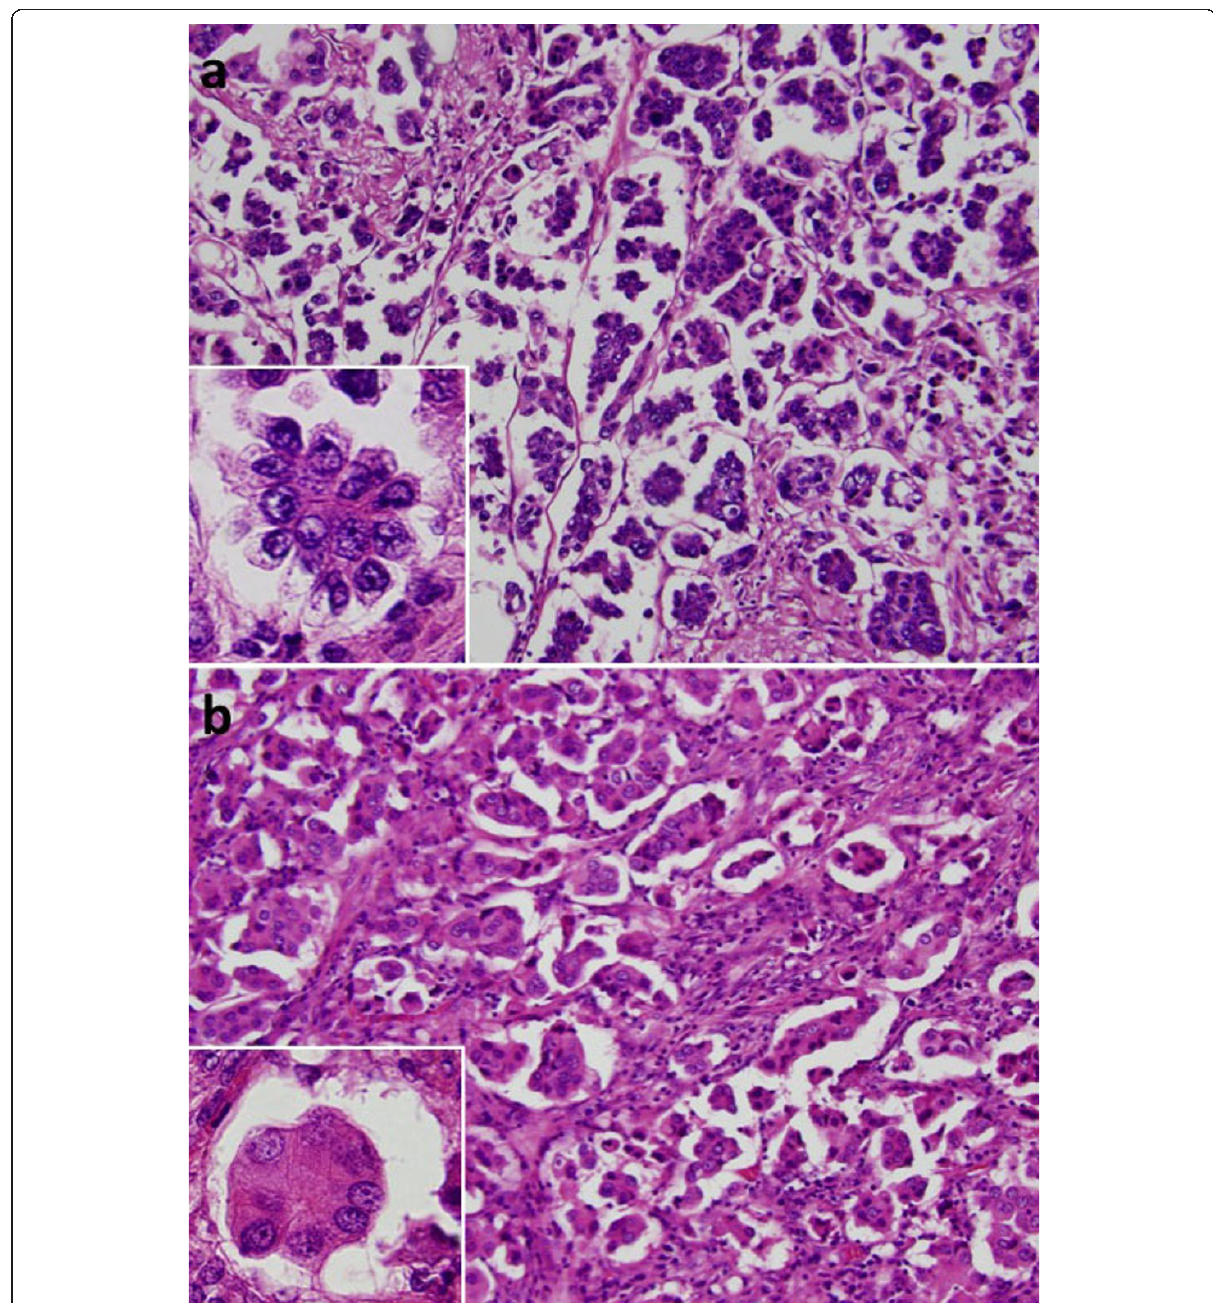
Figure 3 Photomicrographs . Stromal micropapillary pattern characterized by papillary structures with tufts lacking a central fibrovascular core and surrounding clear spaces in fibrotic stroma was seen in both case 1 (a) and case 2 (b). (HE stains ×100; inset,